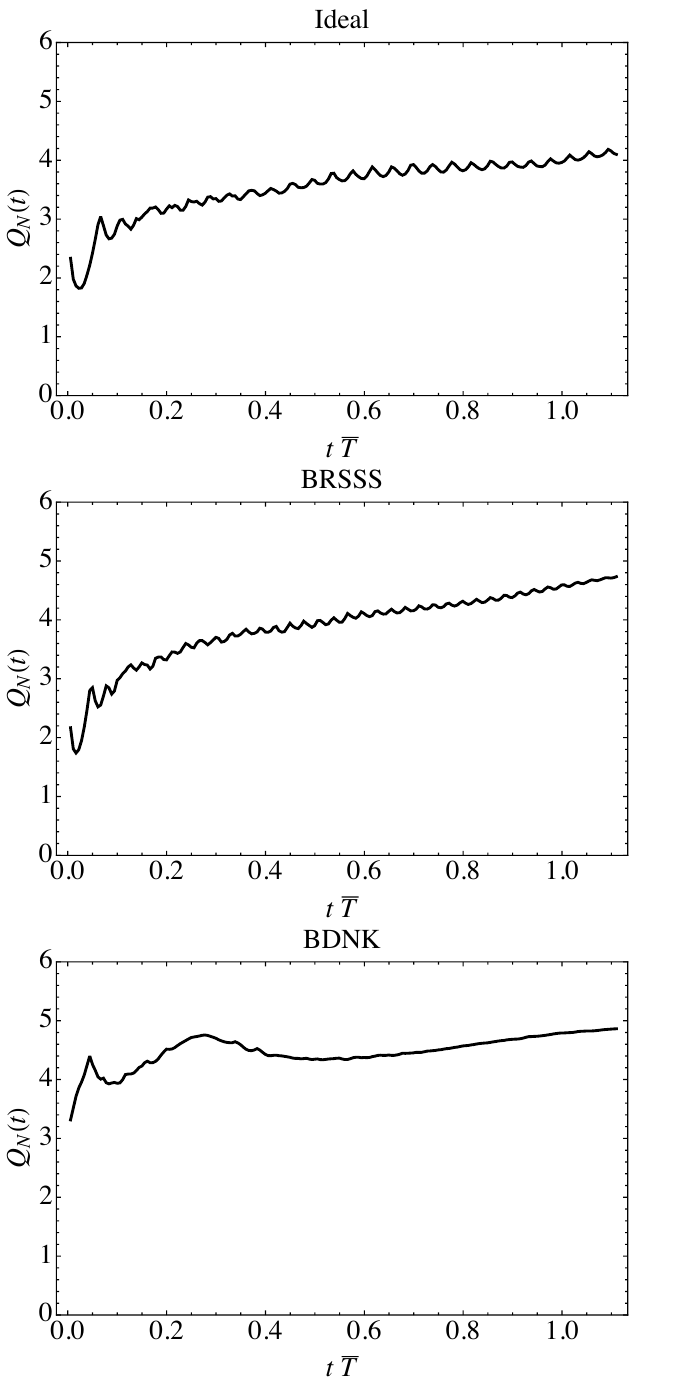
Figure 4 . Convergence tests for our ideal (top), BRSSS (middle) and BDNK (bottom) codes. After an initial transient, the convergence rate approaches (and even surpasses) 4, as one would expect given our differencing and time integration